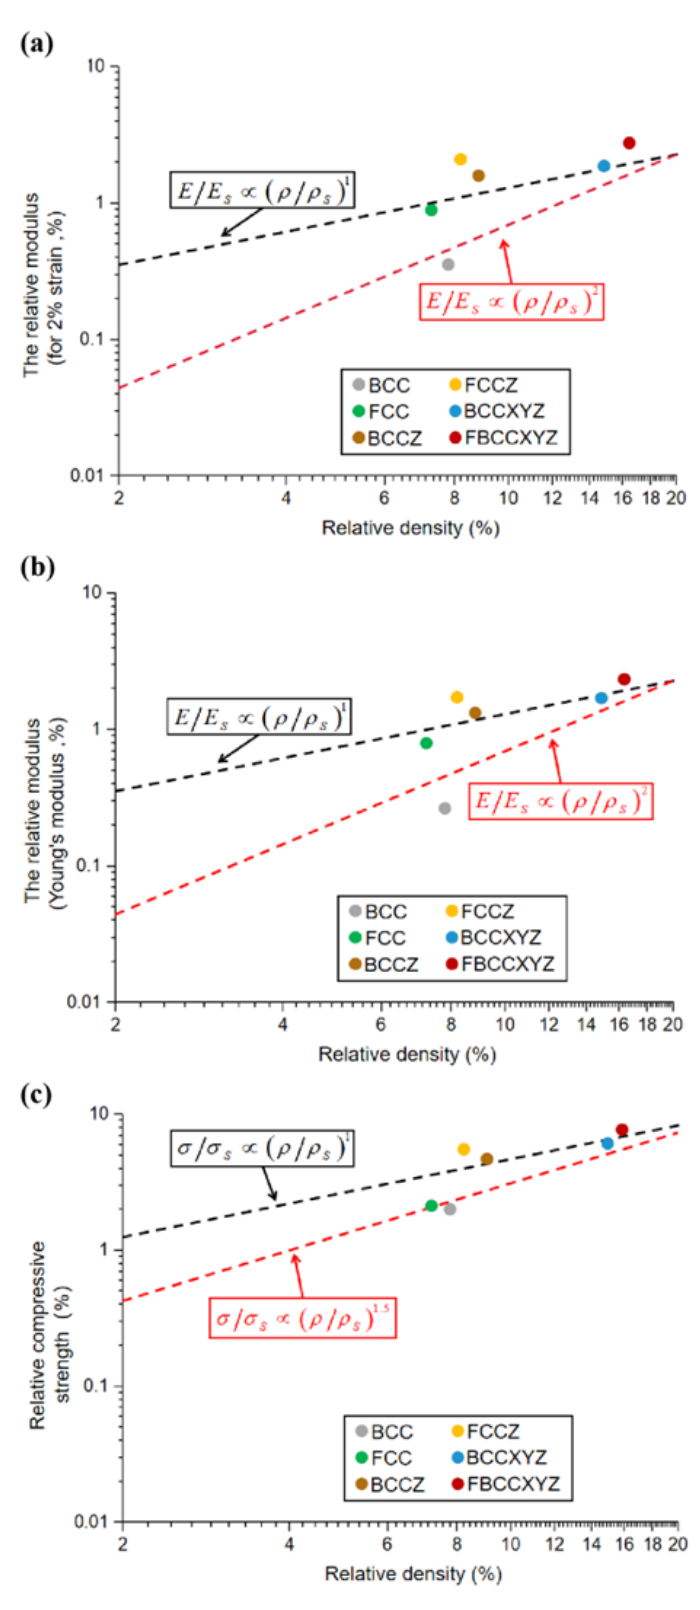
Figure 12. Relationship between relative modulus, compressive strength, and relative density of the lattice structures: ( a ) the relative Young’s modulus, ( b ) the relative modulus of 2% strain, and ( c ) the relative compressive strength.